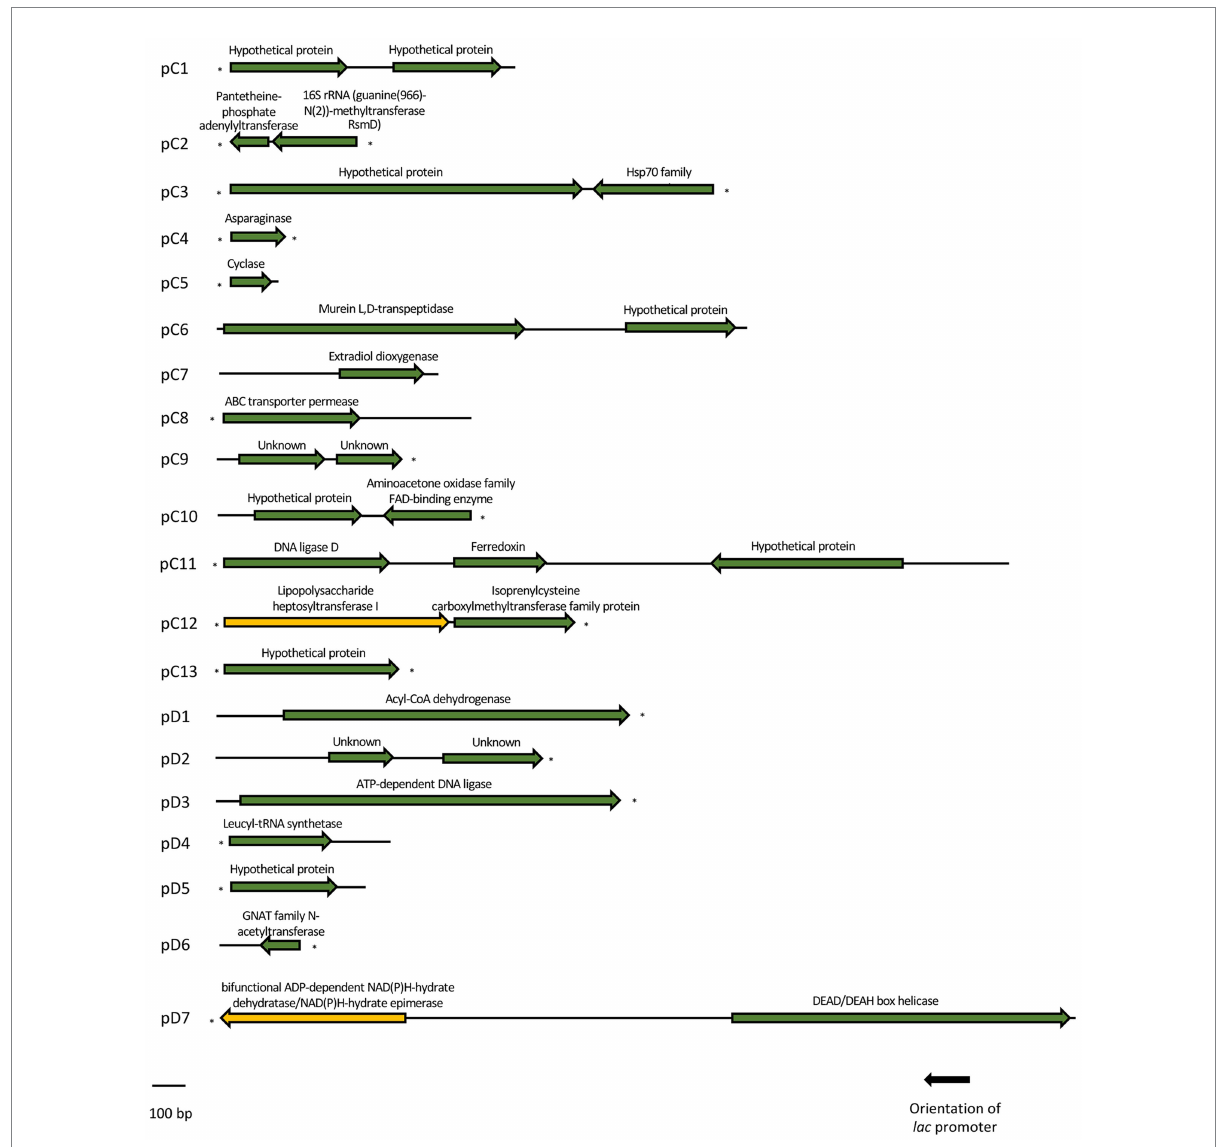
FIGURE 3 Schematic organization of the ORFs identified in each of the 20 cold-resistant clones. Arrows indicate the location and the transcriptional orientation of all the putative genes, being marked in green the ones related to a cold-tolerant phenotype and in yellow the ones that were not related to cold-tolerance. Truncated ORFs are indicated with an